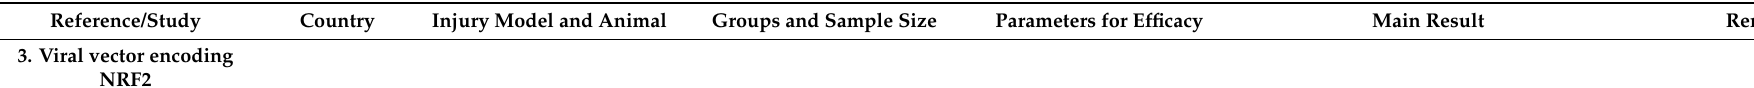
Table 3. Summary of in vivo studies utilizing an AAV vector encoding nuclear factor erythroid 2-related factor 2 (NRF2) as gene